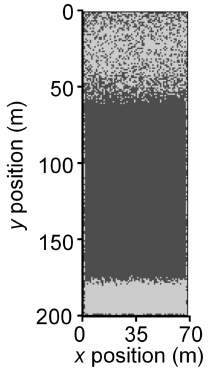
Figure 7. Final micro-habitat map after 100 developmental steps from Model 4, with ∆ t e = 17520h (2yr). Light pixels represent hummocks, dark pixels represent hollows. Low values of y repre- sent upslope locations ( y = 0 is the upslope boundary); high val- ues of y represent downslope locations ( y = 200 is the downslope boundary); as such, groundwater flow is generally down the page.